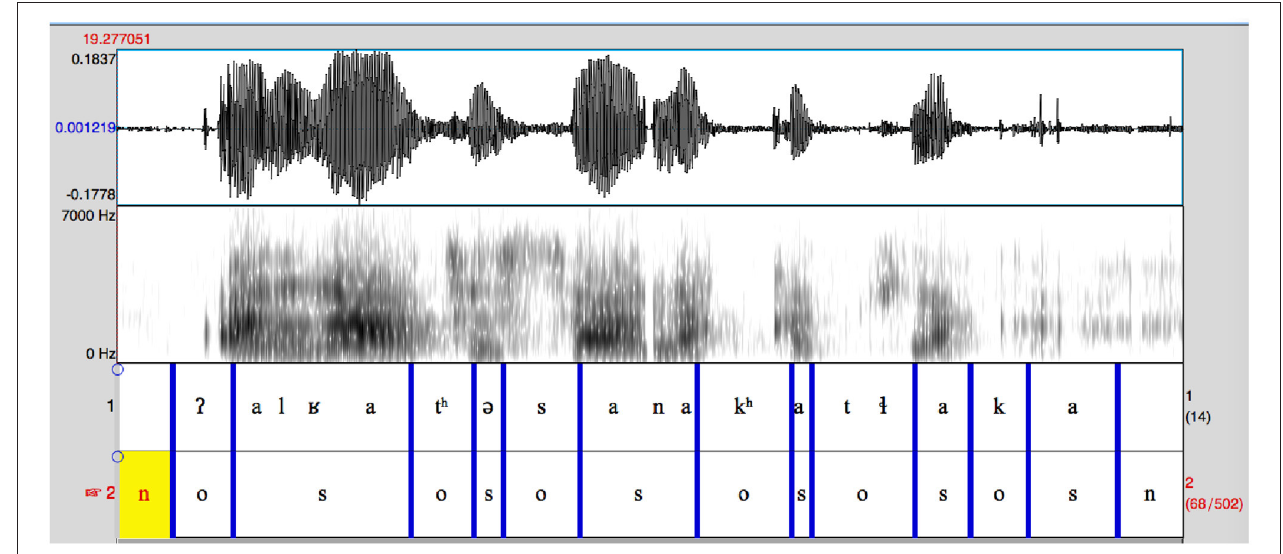
FIGURE 1 | Short extract from Aleut GRN recording.